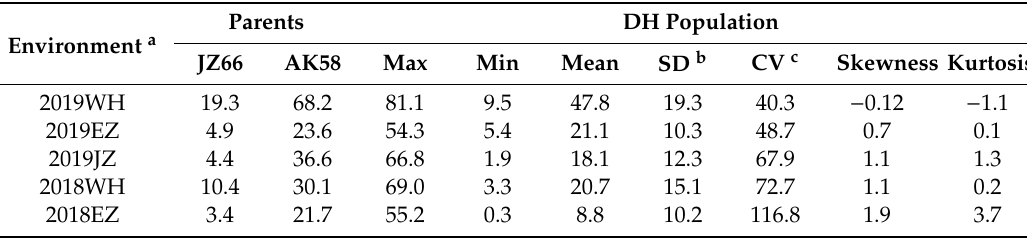
Table 1. Range and mean of Fusarium head blight (FHB) indices of parents and the Jingzhou 66 (JZ66) and Aikang 58 (AK58) doubled haploid (DH)